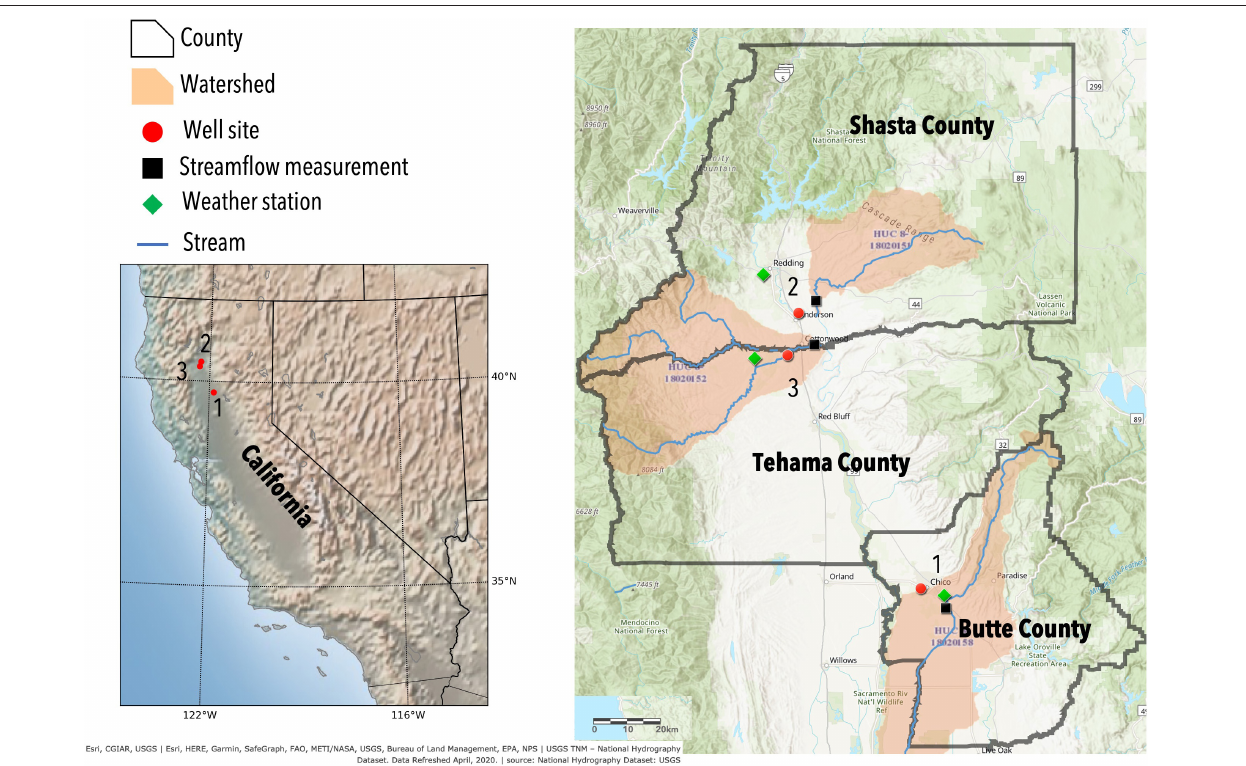
FIGURE 1 | Location of the three well sites in California: Butte, Shasta, and Tehama County. The red dots show the location of the observation wells. Weather station (green diamond) and river flow monitoring station (black square) are located close to the well site. The map was created using ArcGIS ® software by Esri.